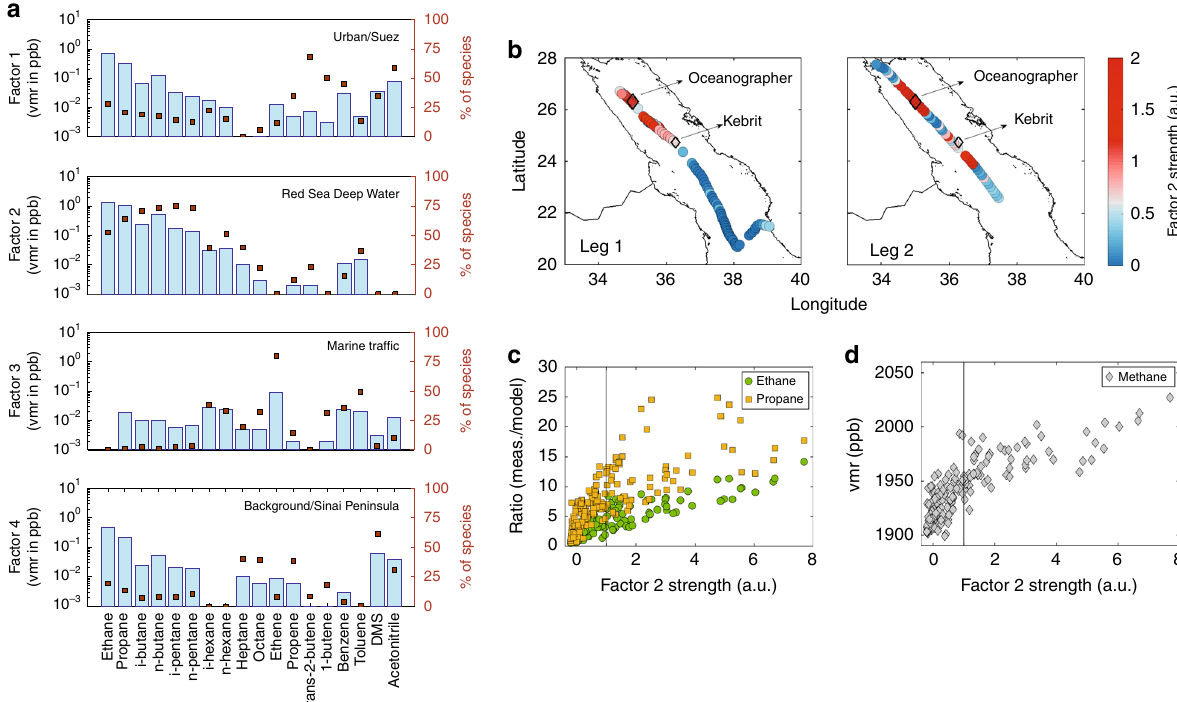
Fig. 2 Source apportionment for the northern Red Sea region. a Pro fi les derived from positive matrix factorization (PMF) analysis. The blue bars indicate the volume mixing ratio contribution from each source and the brown squares the % contribution of each species to the respective factor (sum of factors = 100%). In b , factor 2 strength (average strength = 1) timelines are illustrated for both legs. In c , factor 2 strength is correlated with the ratio between measurements and models for ethane and propane, and in d with the measured methane. Further explanation on the source assignment for each factor is shown in Supplementary Figs. S8 –